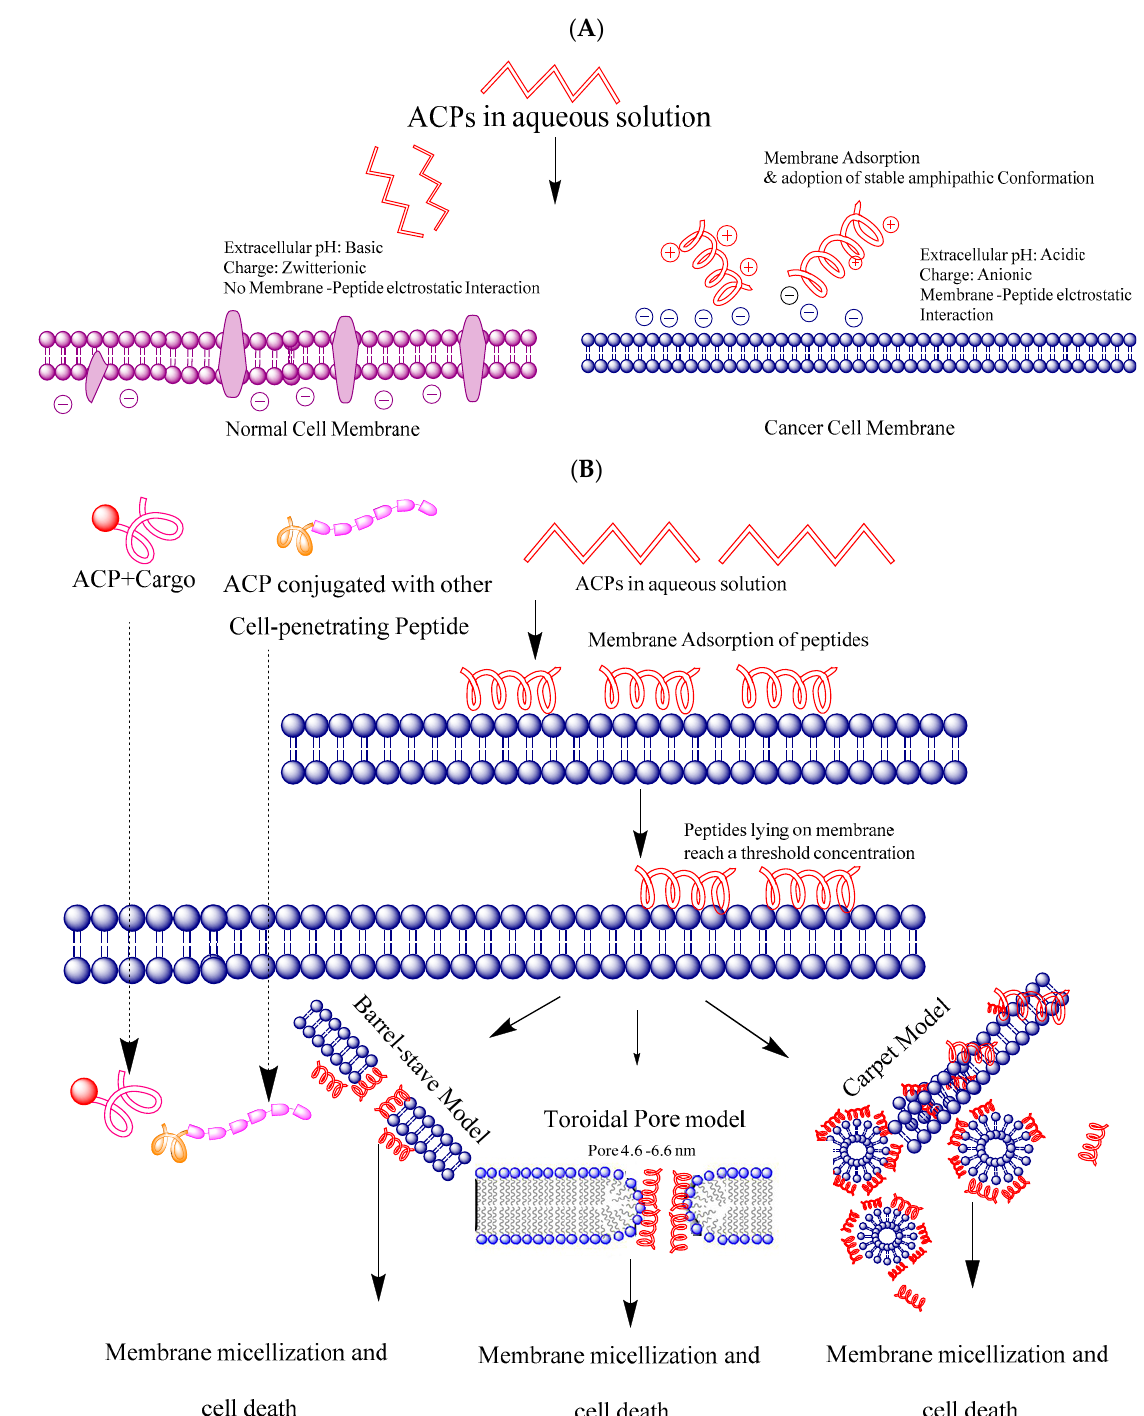
Figure 3. Cell Selectivity and Models of cancer cell membrane permeation by ACPs. ( A ) ACPs fail to attain the stable secondary structure in a normal cell membrane microenvironment due to zwitterionic charge and basic pH. The ACPs interact with anionic lipids of the cancer cell membrane to initiate anti-cancer activity. ( B ) The peptides directly penetrating the membrane can be used to deliver cargo into the cell. The non-permeable peptides can be conjugated with Cell-penetrating peptides (CPP) to facilitate their entry into the cell. Other peptides can breach the membrane integrity by Barrel-stove, Toroidal pore, or carpet model after interacting electrostatically with the cancer cell membrane.